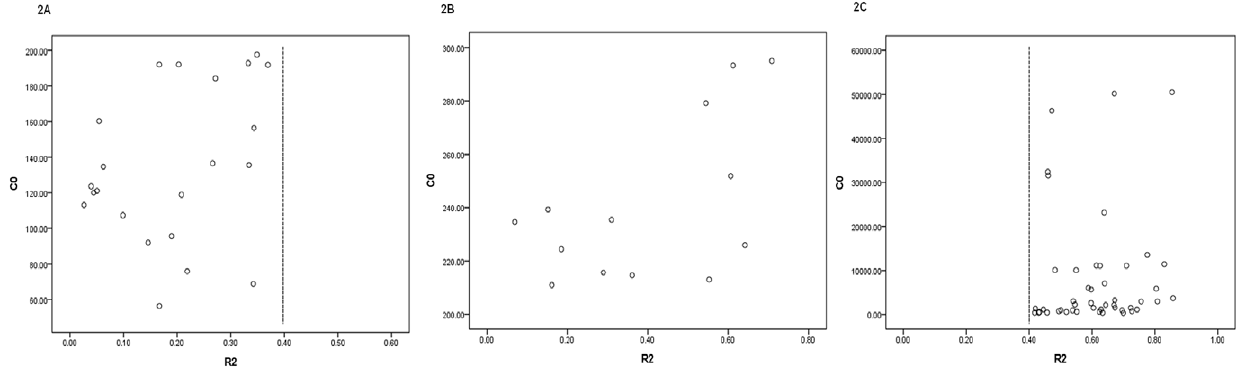
Figure 2. The relationship between C 0 and the overall PQ clearance rate (R 2 ) (C 0 , 4000 ng/ml). C 0 stands for the plasma PQ concentration at the beginning of haemoperfusion, R 2 stands for the overall PQ clearace rate of haemoperfusion. Figure 2A stands for patients in group A with C 0 # 200 ng/ml; Figure 2B stands for patients in group B with 200 , C 0 # 300 ng/ml; Figure 2C stands for patients in group C with C 0 . 300 ng/ml.